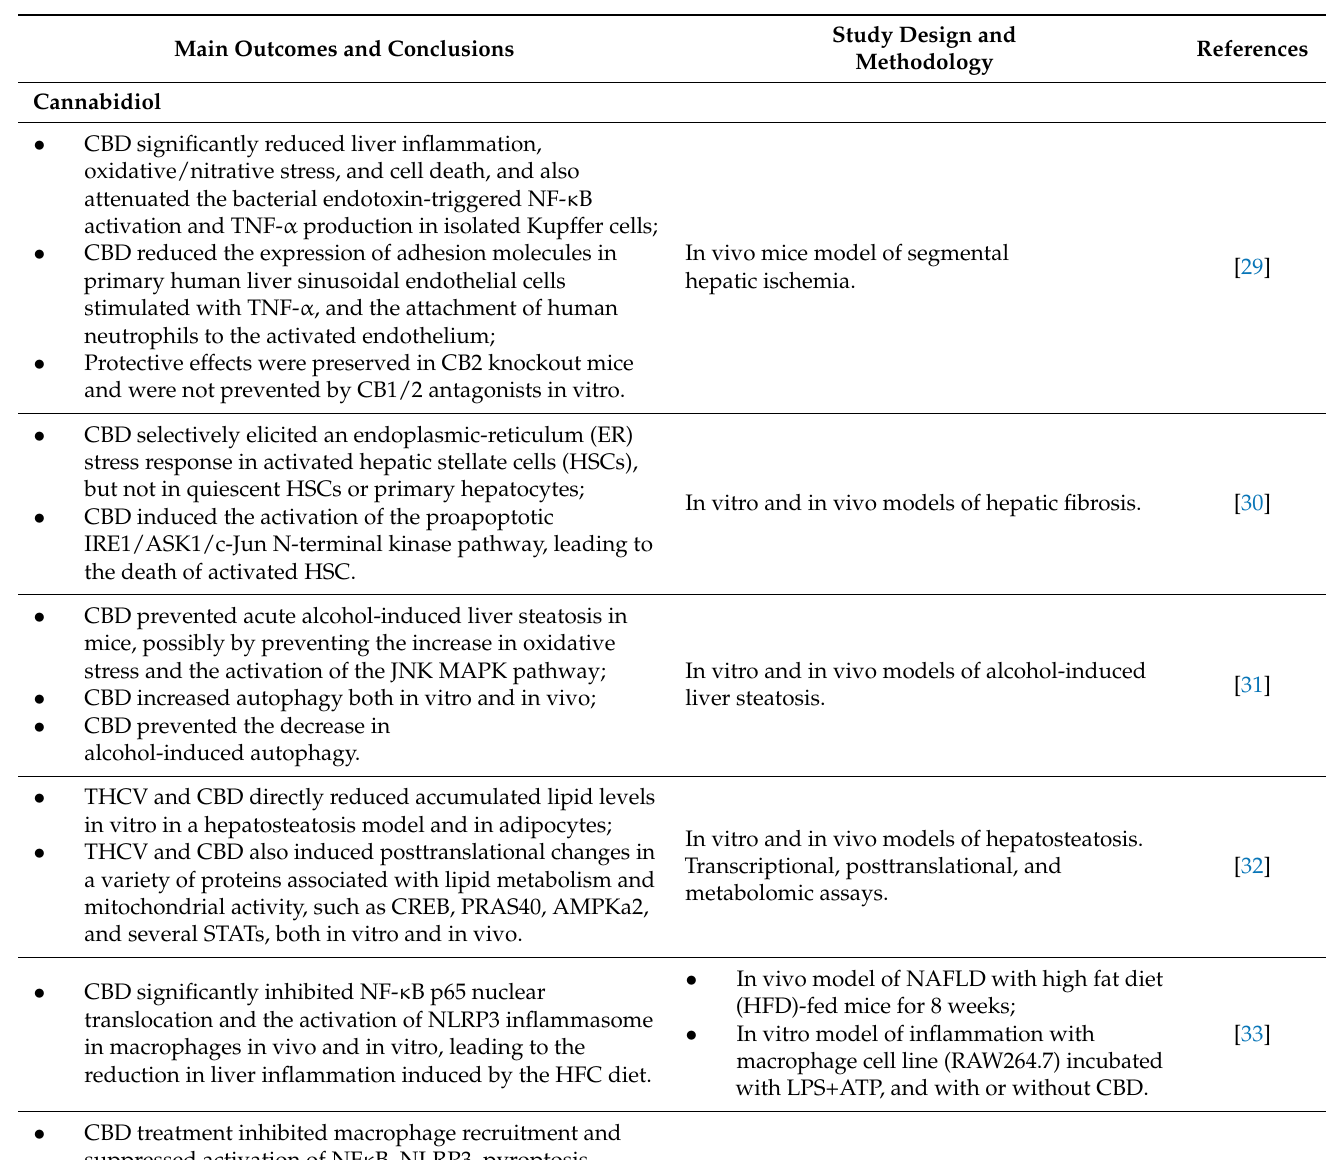
Table 1. Preclinical and clinical studies assessing the effect of cannabinoid-based medicine on chronic liver